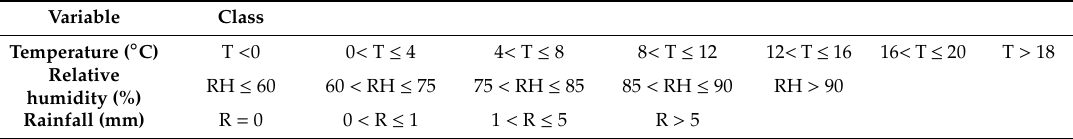
Table 2. The classes of air temperature (T), relative humidity (RH) and rainfall (R) considered with hourly data in the frequency analysis for each week during the March–May period.